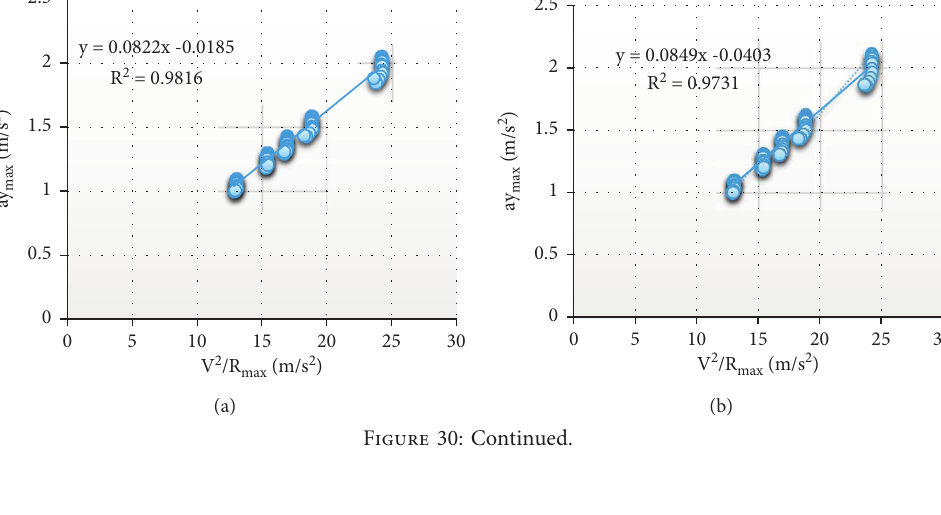
y = 0.0822x -0.0185 R 2 =